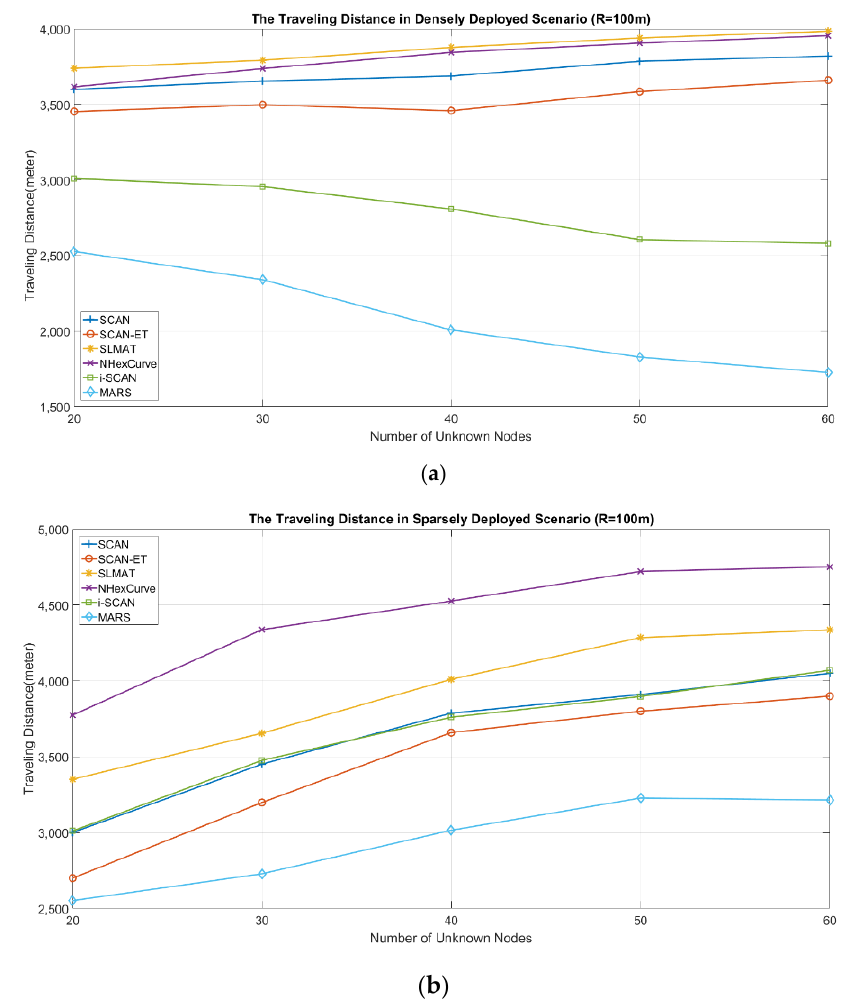
Figure 8. The traveling distance in the dense and sparse deployment scenarios. ( a ) Dense deploy- ment scenario, which is the scenario favorable for the ISP algorithm. The topology of the deployed unknown nodes is a strongly connected graph. Each unknown node can be connected to any other node. ( b ) Sparse deployment scenario, which is the scenario unfavorable for the ISP algorithm. The unknown nodes are not able to find any neighbor nodes within their communication range.